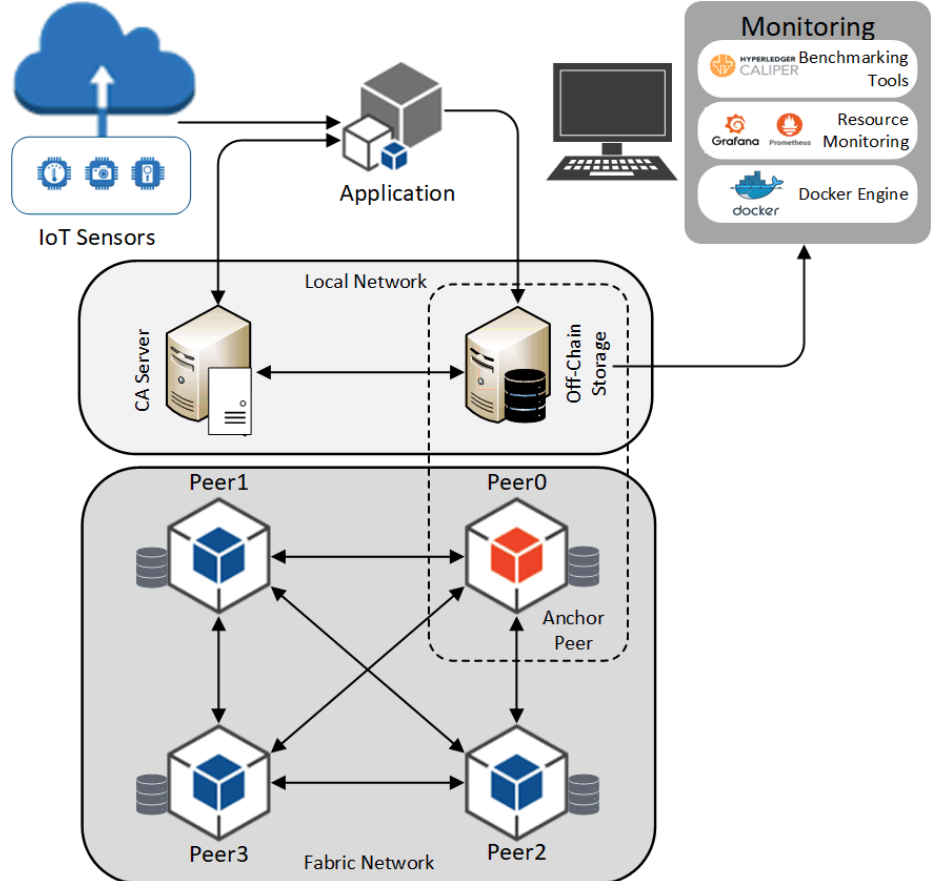
Figure 3. HLF-based distributed system model (the peers and off-chain storage are separated into a scalable